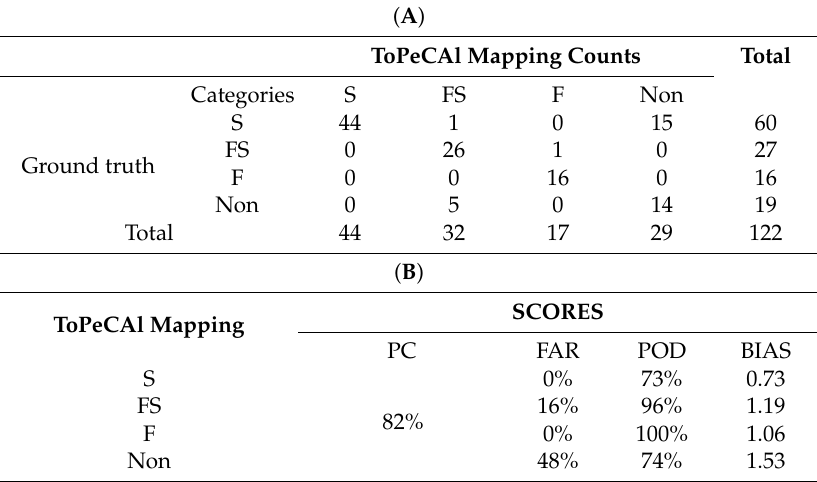
Table 6. ( A ) The results of Contingency Table of ToPeCAl validation in Central Kalimantan and Riau Province (data in table shows counts), and ( B ) the scores of PC, FAR, POD, and BIAS of ToPeCAl Mapping compared with ground truth data. ( A